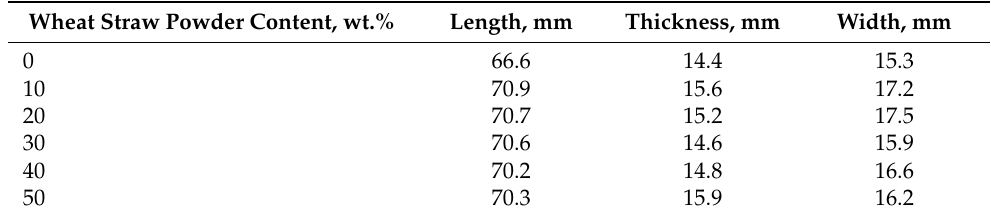
Table 2. Geometric parameters of the studied samples of polymer composites with wheat straw powder.